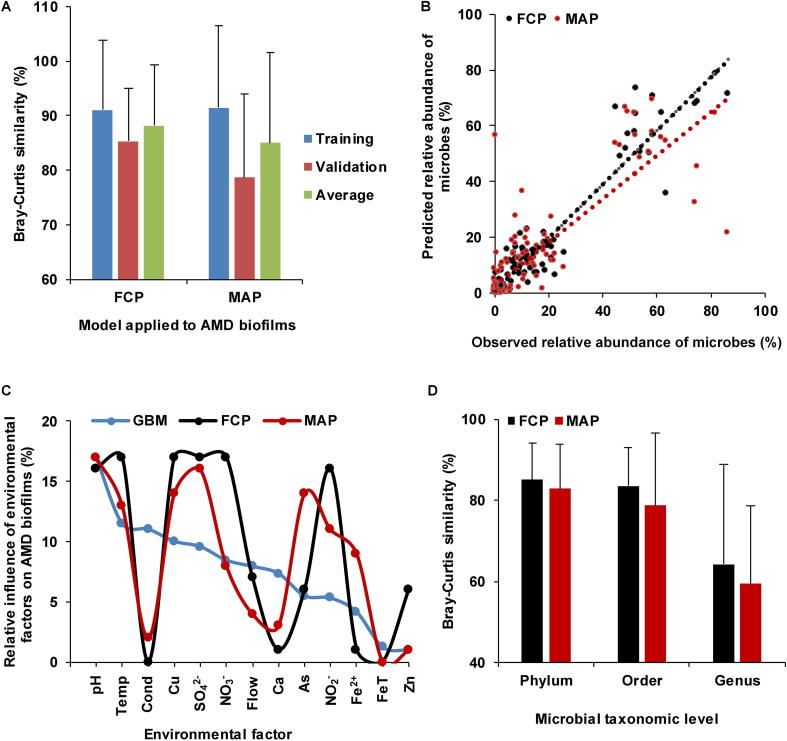
Comparison of prediction accuracies between the FCP and MAP methodsA. Prediction accuracies of the FCP and MAP methods in AMD samples. The prediction accuracies for the training dataset and validating dataset in AMD samples are measured using Bray–Curtis similarity, with the average accuracies also shown. B. Cross-validation of the predicted relative microbial abundances with MAP and FCP methods in AMD communities. The linear regression of the FCP model is expressed as y = 0.96x + 0.003 (R2 = 0.92) and that of the MAP model is expressed as y = 0.79x + 0.03 (R2 = 0.72), respectively. C. Relative influence of environmental factors on AMD biofilms using GBM, FCP, and MAP methods. D. Comparison of prediction accuracies between the FCP and MAP models in human gut microbiota samples. The accuracies are measured using Bray–Curtis similarity. FCP, functional gene-based composition prediction; MAP, microbial assemblage prediction.